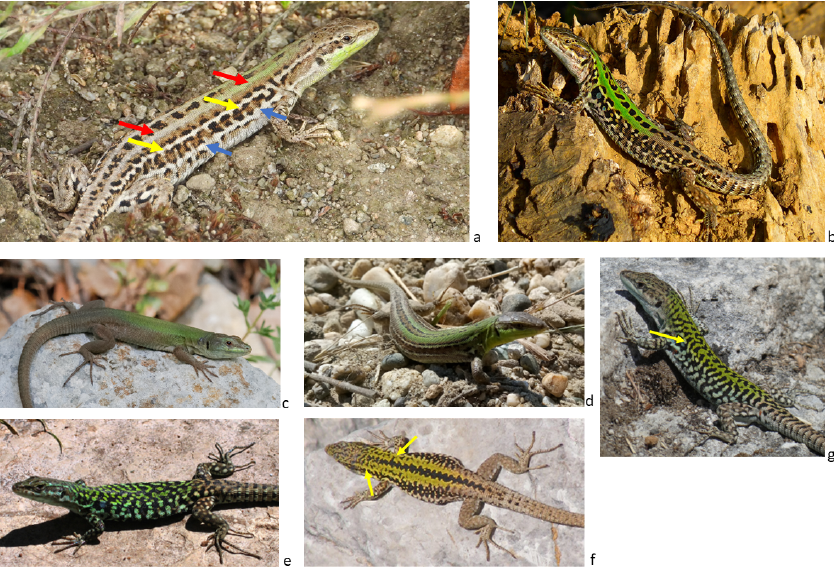
Figure 1. ( a ) Position of the characters used to define the dorsal pattern phenotypes; parietal, supraciliar, and lateral stripes are indicated by red, blue, and yellow arrows, respectively (observation by Mirko Tomasi https://www.inaturalist.org/observations/51132755, accessed on 5 April 2021). ( b ) “Campestris” phenotype (observation by Renato